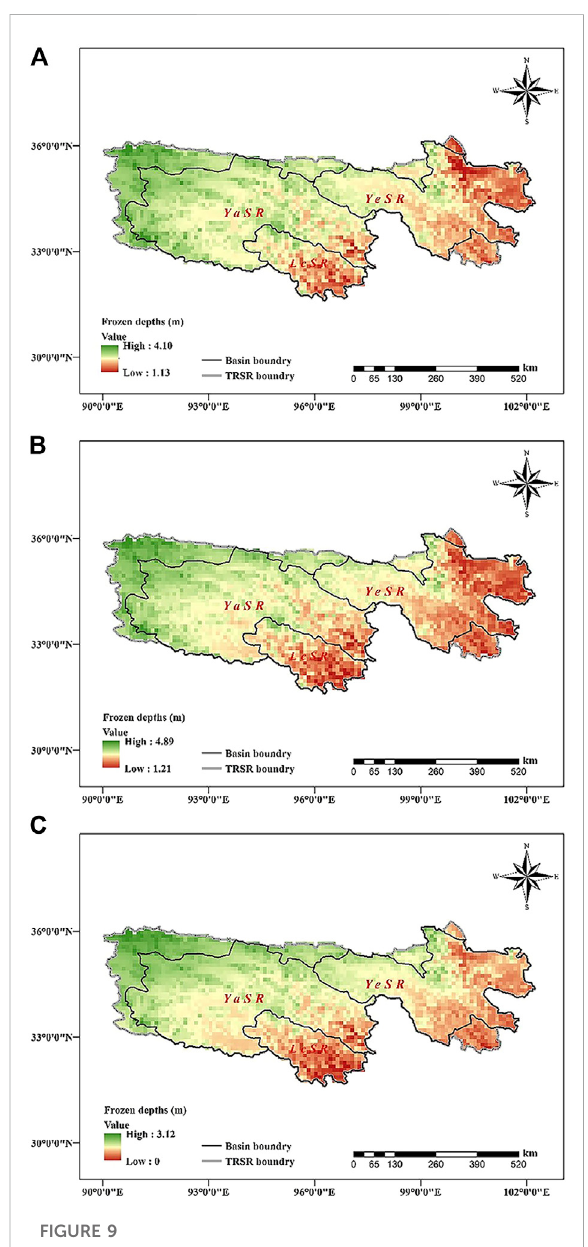
FIGURE 9 Spatial distribution of frozen depths in the TRSR in (A) 1 January 2007, (B) 1 February 2007 and (C) 1 March